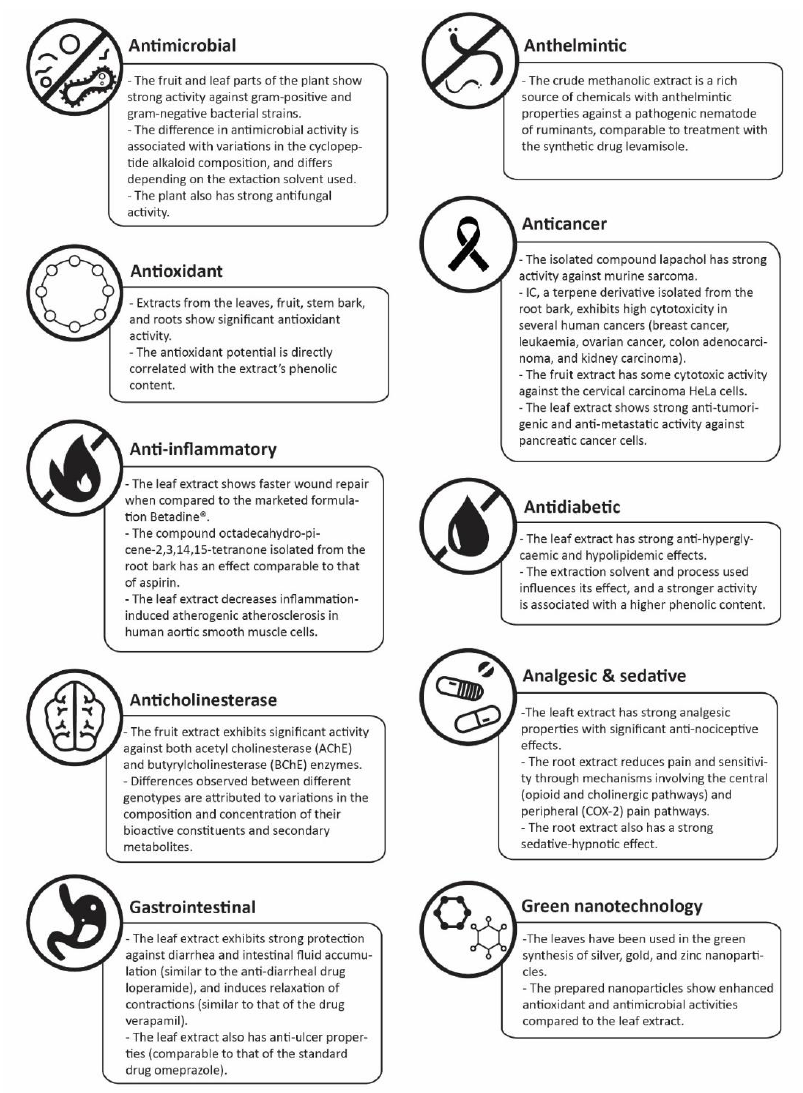
Figure 2. Reported therapeutic applications of Ziziphus nummularia.